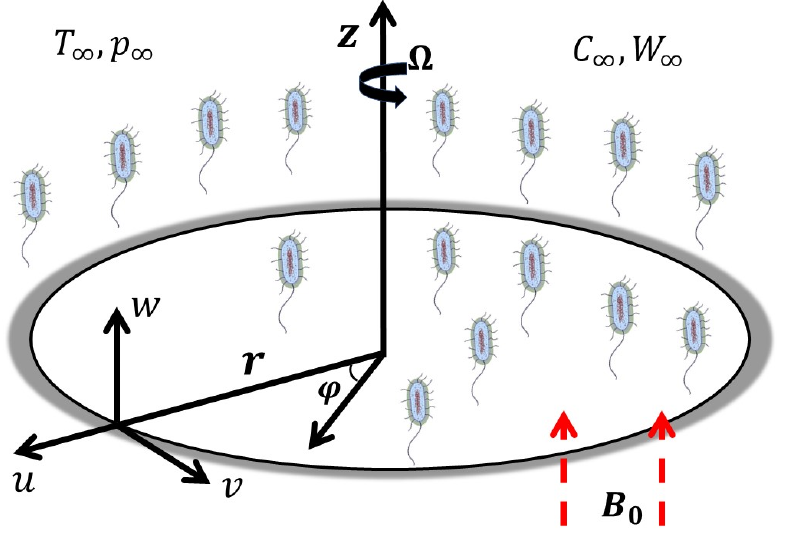
Figure 1. Physical configuration of the problem.